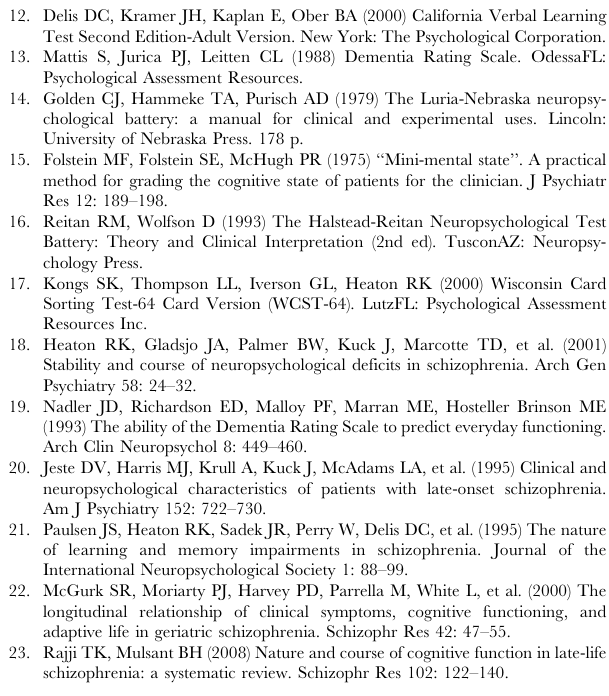
Table S1 LLS: late-life schizophrenia; AD: Alzheimer’s disease; DEP: depressive disorder; NC: normal cognition. -- All results presented as mean scores (SD) unless specified otherwise. *: group(s) significantly different from LLS after Bonferroni’s correction **: duration of illness available for 13 patients with LLS, 1 patient with DEP, and no one with AD or NC [n] = number of individuals contributing to the mean {n} = Cohen’s effect size of the comparison between AD, DEP, or NC group with LLS